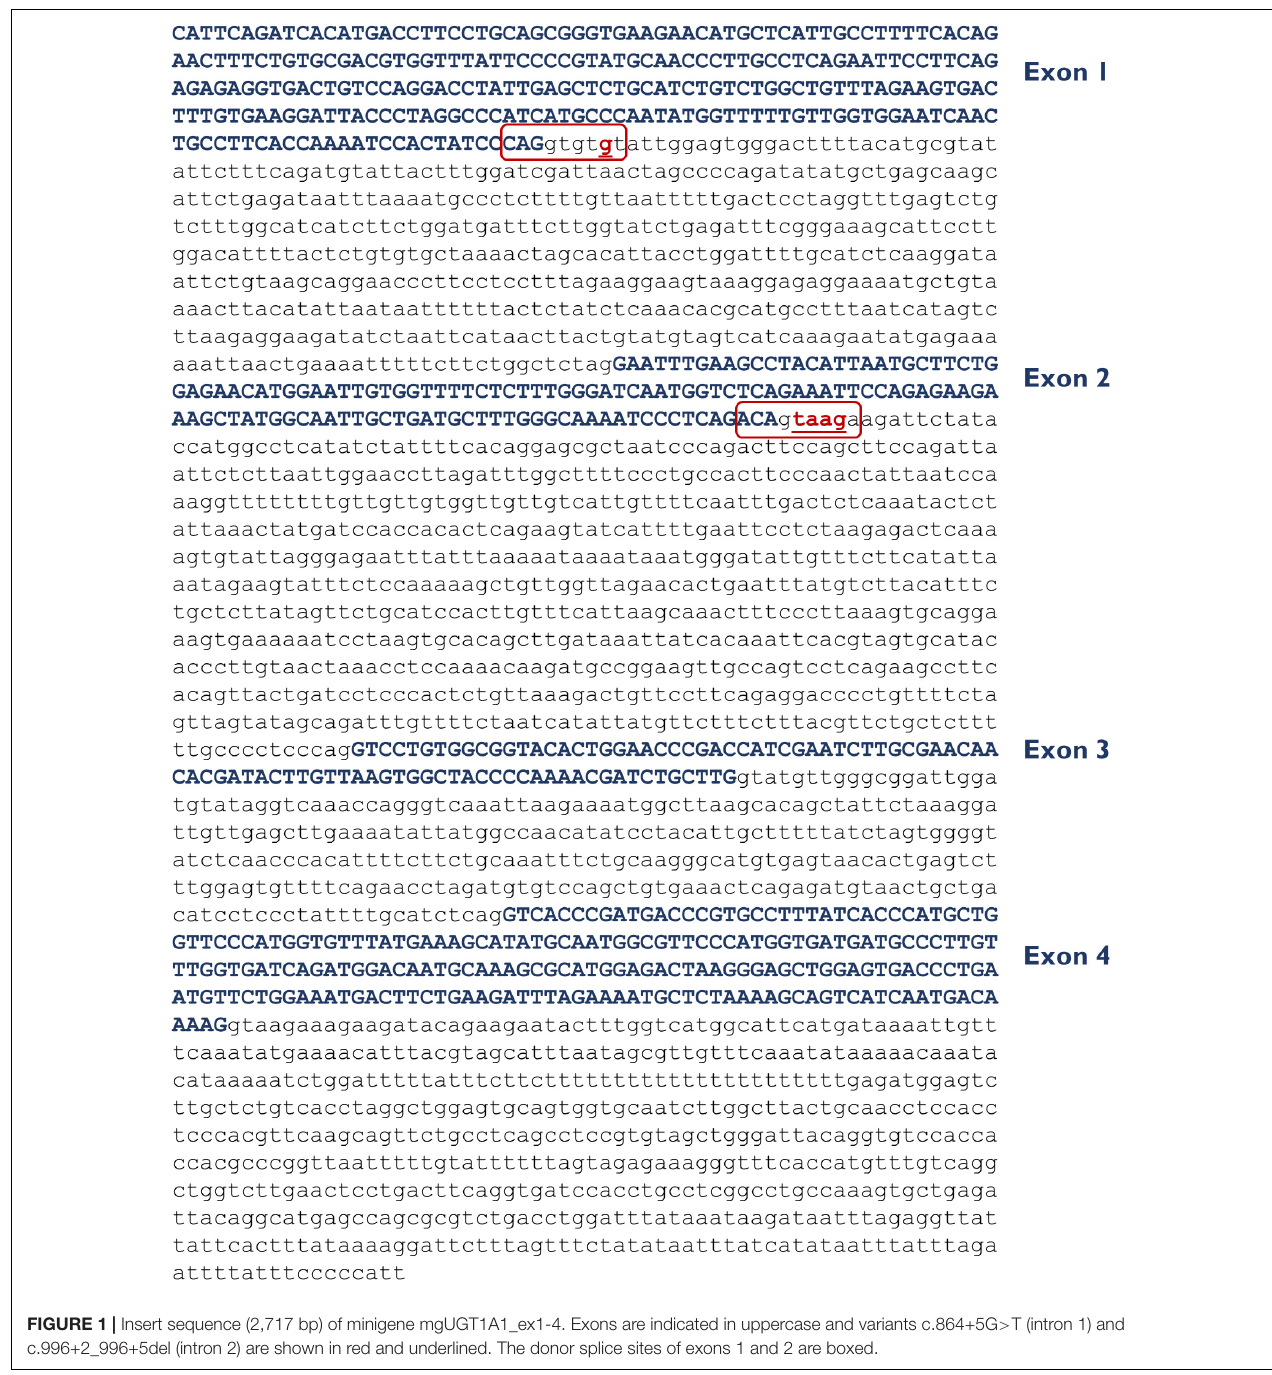
(p.Val242_Gln288del) of the N-terminal domain that encodes for substrate specificity of UGT1A1. The overall conservation of the UGT1A1 protein in vertebrates is 30.2% (161 out of 533 amino acids; Supplementary Figure S1 ). Particularly, 12 amino acids (25.5%) of the interval Val242_Gln288 are strictly conserved in vertebrates and 25 in mammals ( Figure 3A ), suggesting a relevant role in UGT1A1